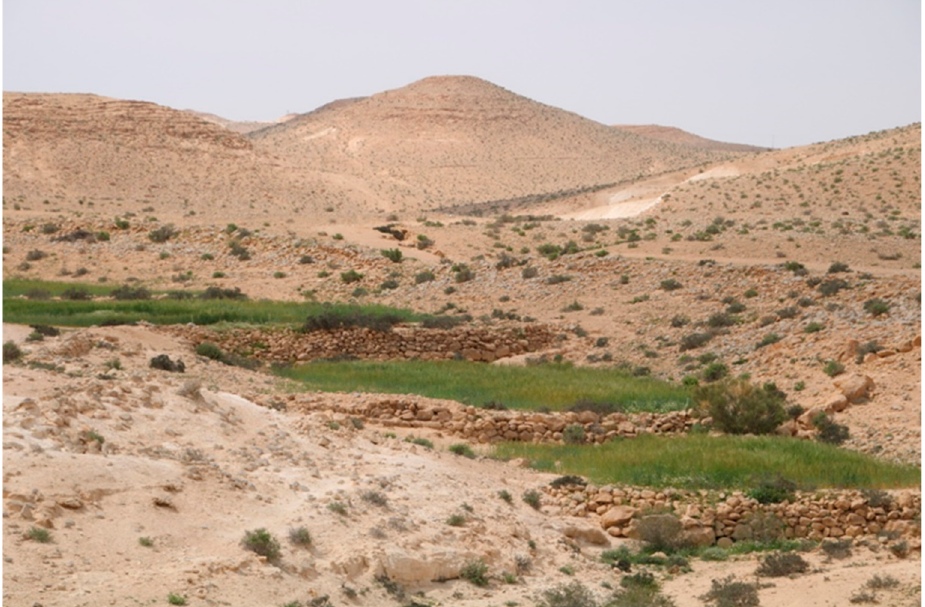
Figure 4. Ancient agricultural plots used for cereal cultivation in the Negev Highlands, expressing the agricultural potential of the region. Note the exposed bedrock that generated the runoff harvested for irrigation. (Photograph: Y. Avni).